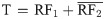
Single perturbation state diagram (SPSD) with two input variables.We introduce the SPSD to be able to show in a graph all state transitions of the regulators (RF1 and RF2) and the target gene (T) due to the knock-down (D) and over-expression (O) perturbations. The Boolean function T=RF1+RF2¯ is studied here. The blue, red, and green items correspond to the initial steady state, over-expression, and knock-down, respectively. A: The initial state of the inputs is 01. Both O1 and D2 perturbations cause a change in the state of T. Therefore, both corresponding edges in the SPSD are solid-line arrows. The upper and lower half of each node in the SPSD shows the state of the inputs and output, respectively. B: The initial state of the inputs is 11. D2 does not make any change in the output state; hence, the effect of RF2 on T is not visible (visibility problem), and the corresponding edge in the SPSD is a dashed-line arrow. C: The complete SPSD of the Boolean function for all possible initial states. D: The graph representation of the function T=RF1+RF2¯.